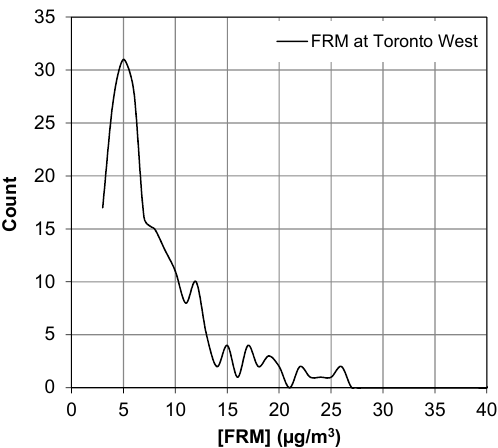
Figure 2. Frequency distribution of 24 h FRM concentrations from the period of 2013–2016 at the Toronto West station.